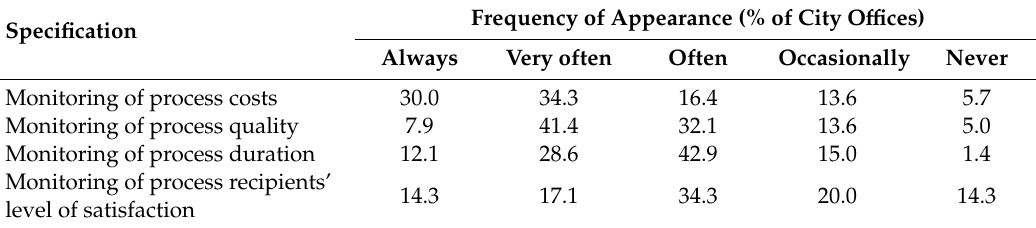
Table 2. Community o ffi ces in which process characteristics are being monitored (n =